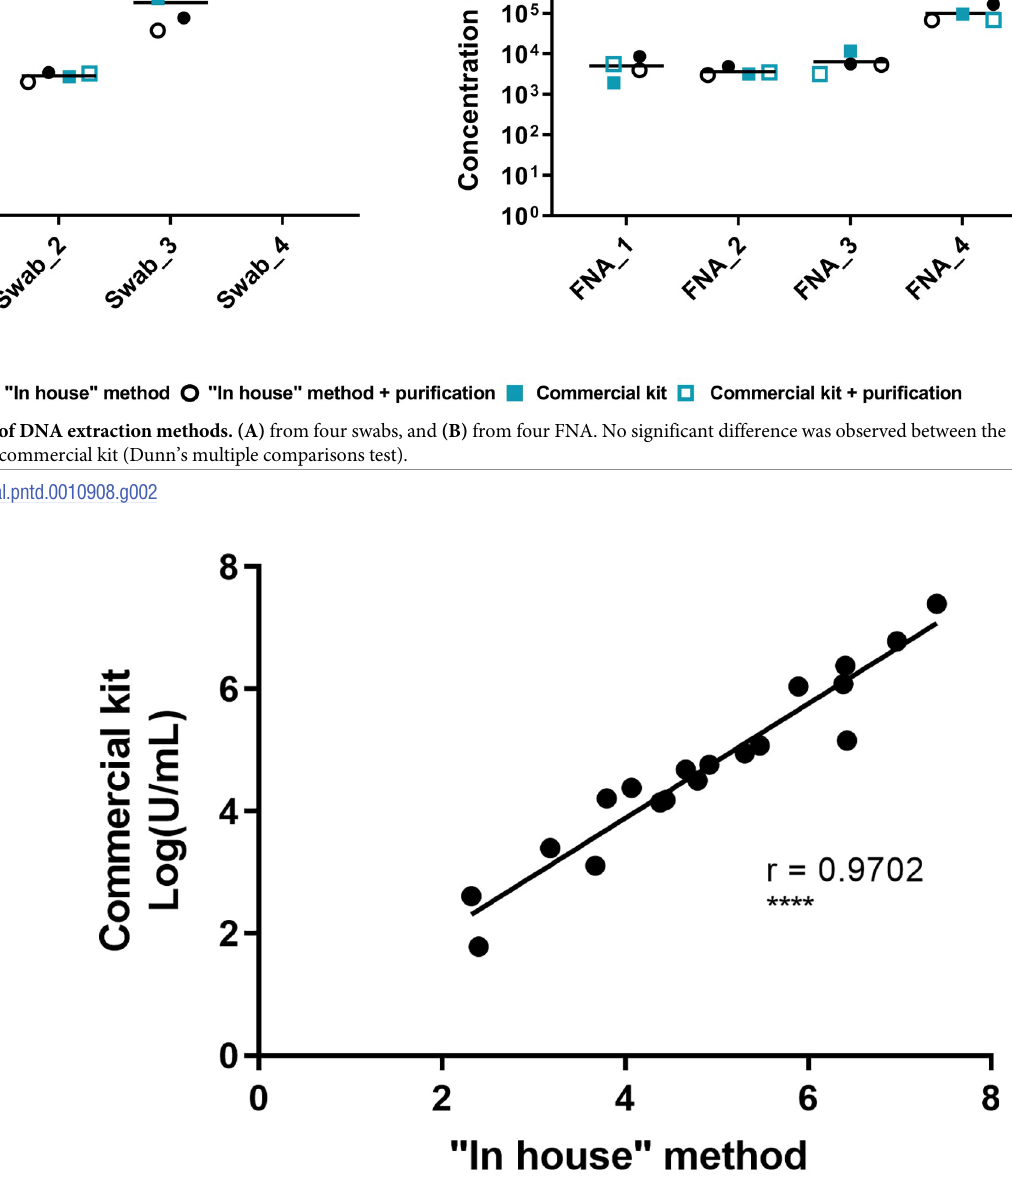
PLOS NeglectedTropical Diseases | https://doi.org/10.1371/journal.pntd.0010908 November4,